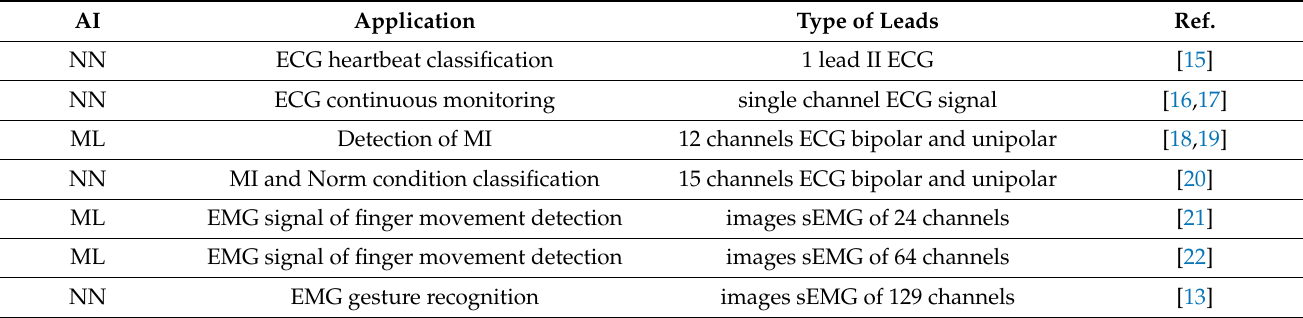
Table 1. Summary of the literature referring to ECG prediction models.